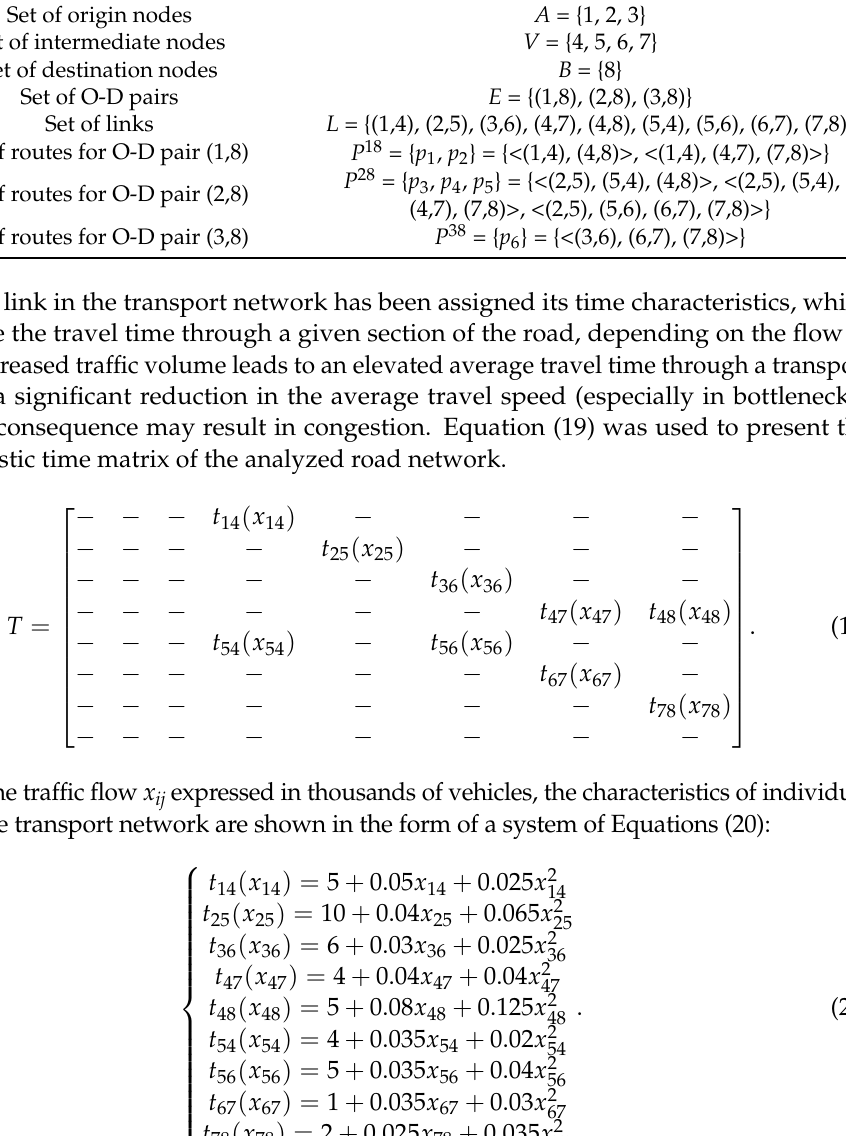
Table 2. Characteristics of transport network. Element of Model Mathematical Notation